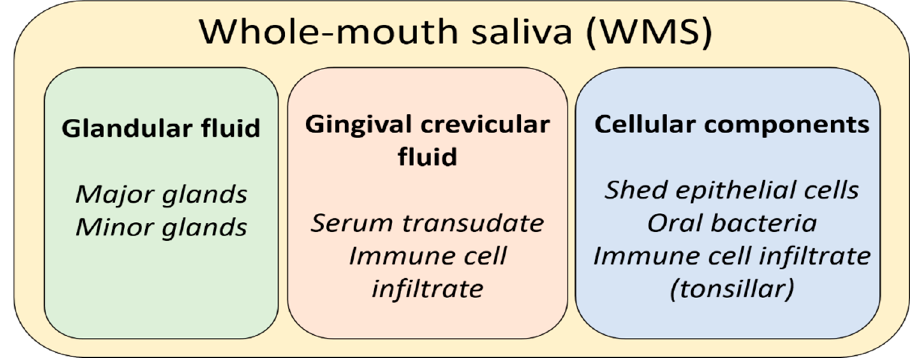
Figure 1. A summary of the net contributions to whole-mouth saliva.